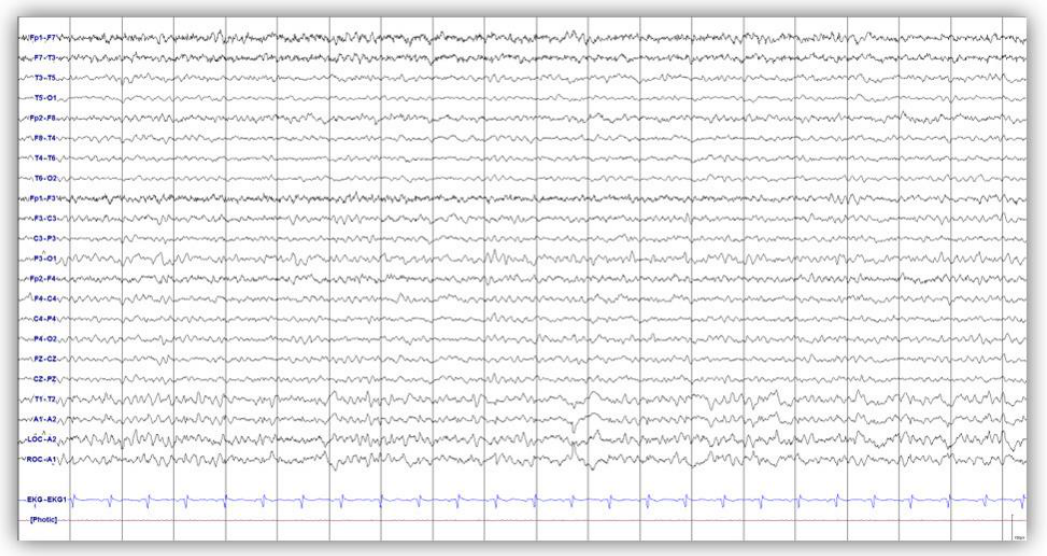
Figure 5. Electroencephalogram (EEG) performed five years after deep brain stimulation showed a reduced number and amplitude of slow-wave discharges, with no evidence of generalized spike or polyspikes from prefrontal or prefrontal seen in the previous